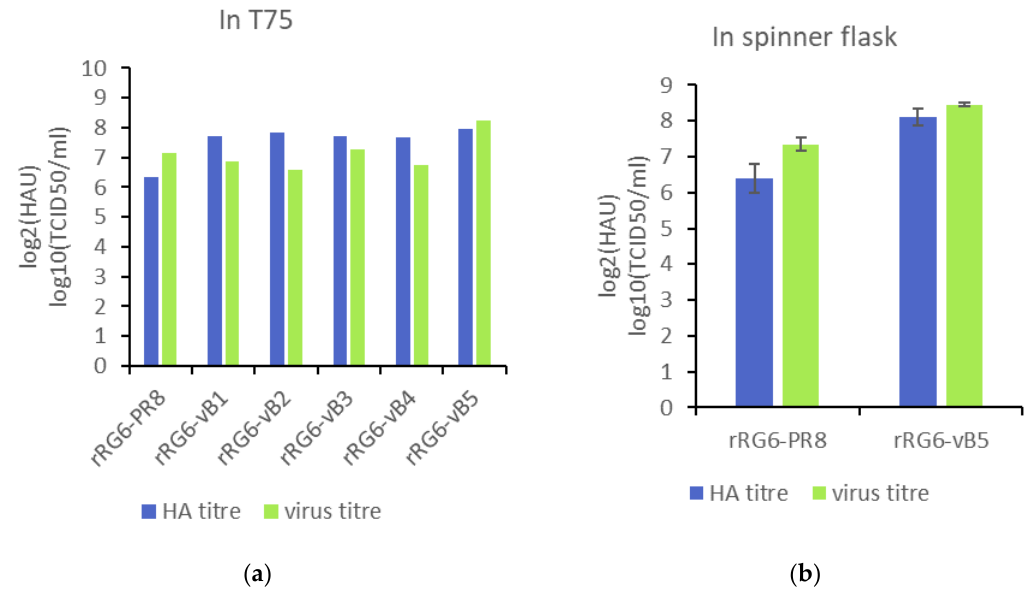
Figure 3. The growth property of reassortant viruses in serum-free medium. The multiplicity of infection (MOI) was 0.0001. TPCK-trypsin was supplied, and the samples were collected every day for Tissue Culture Infective Dose (TCID) assay and hemagglutination assay (HA). ( a ) The peak titer of virus growth in T75 flasks. ( b ) The peak titer of virus growth in spinner flasks.